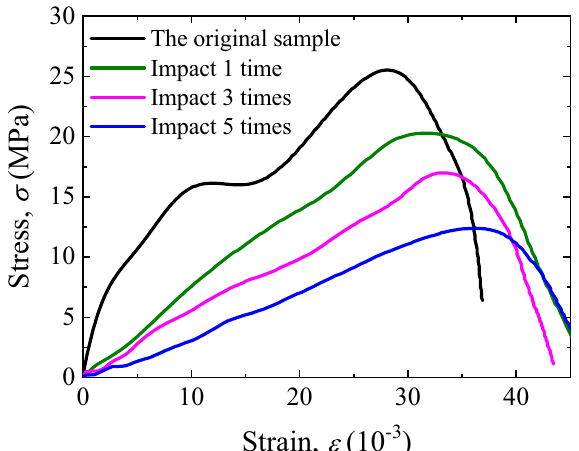
Figure 7. Dynamic stress–strain curves of filled jointed rock specimens after accumulative